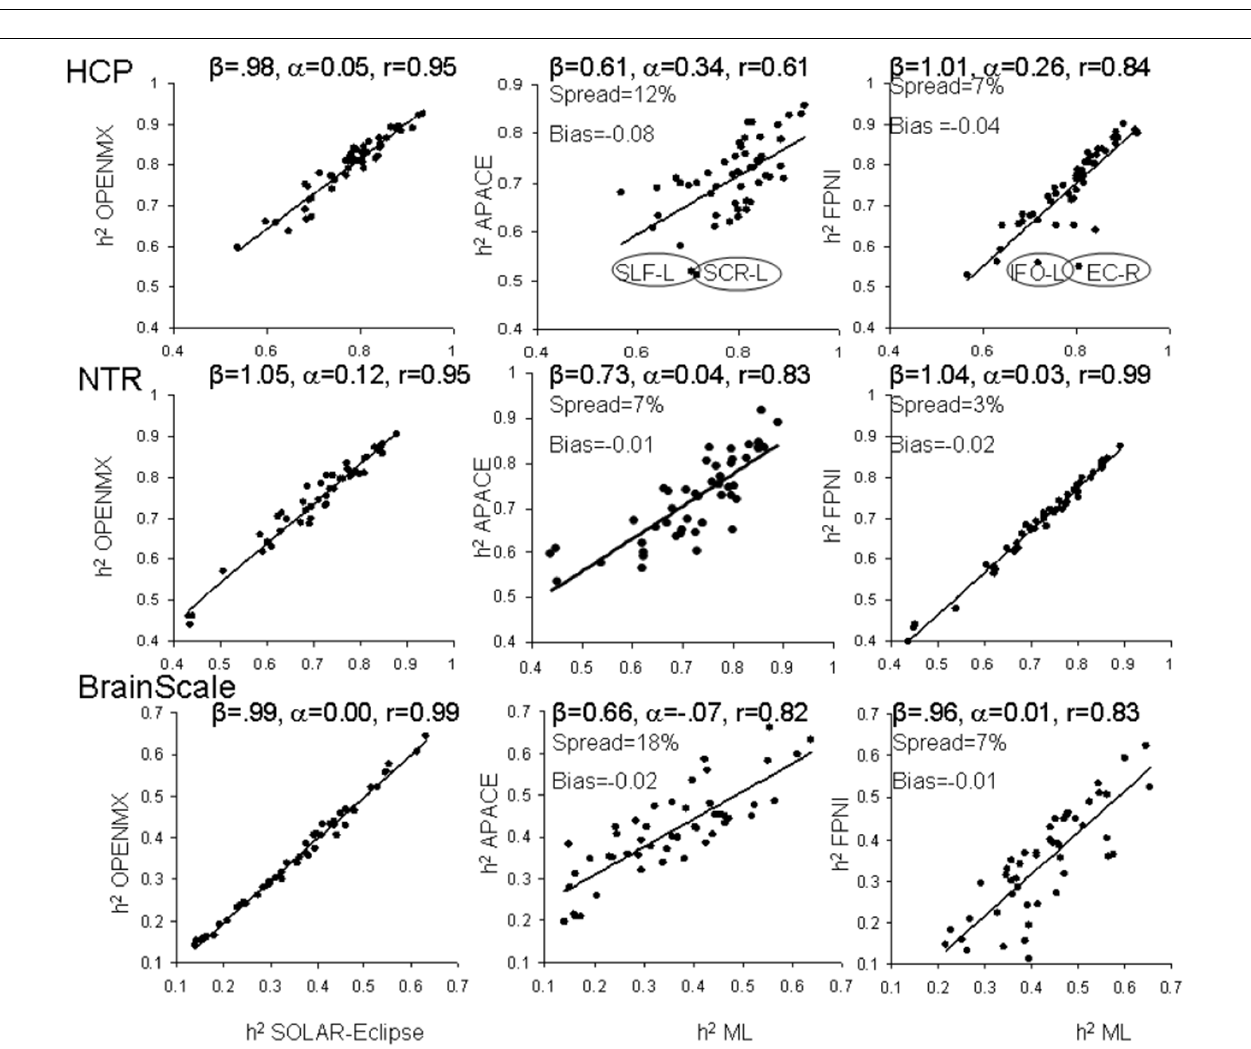
FIGURE 2 | The scatter plot of heritability estimates for 49-regional fractional anisotropy (FA) values calculated by the enhancing neuro imaging genetics analysis (ENIGMA)-diffusion tensor imaging (DTI) pipeline. Heritability estimates for two approximation approaches were plotted vs. the average estimate obtained for two ML-based methods: SOLAR-Eclipse and OpenMX. The lines represent linear regression fit vs. ML-based estimates with slope ( β ), intercept ( α ) and Pearson correlation values (r).